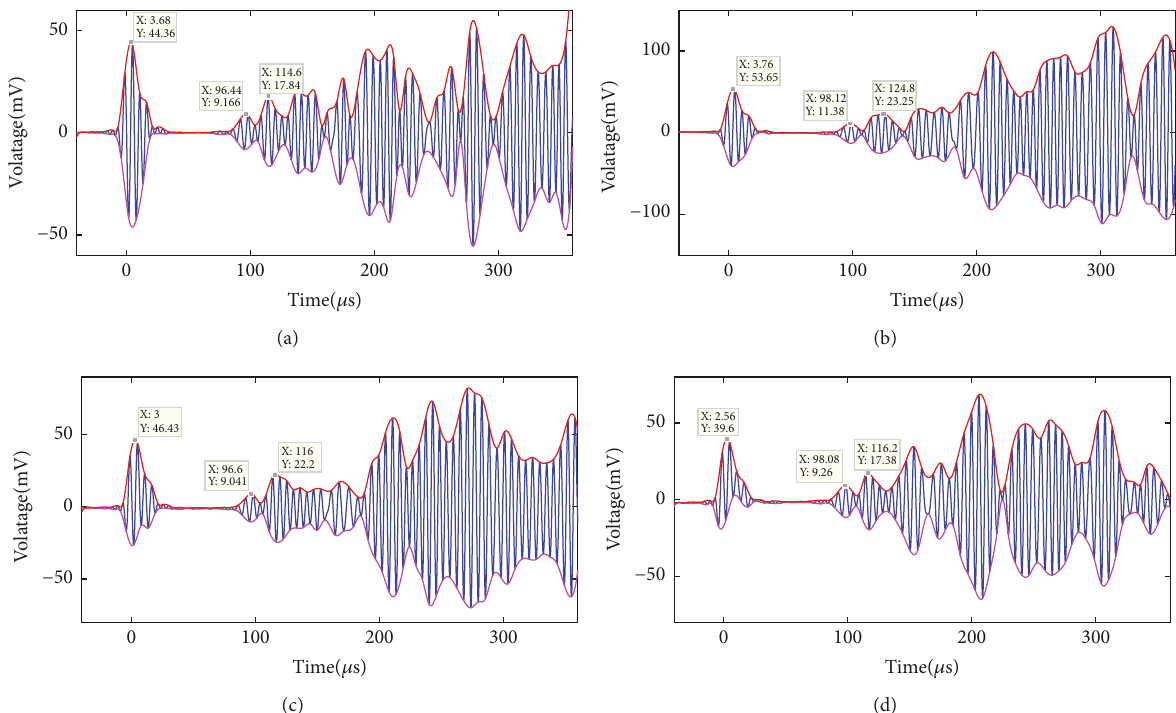
Figure 7: Collected signals of piezoelectric transducers after filtering (a) no. 1, (b) no. 2, (c) no. 3, and (d) no. 4 when the rotor is at